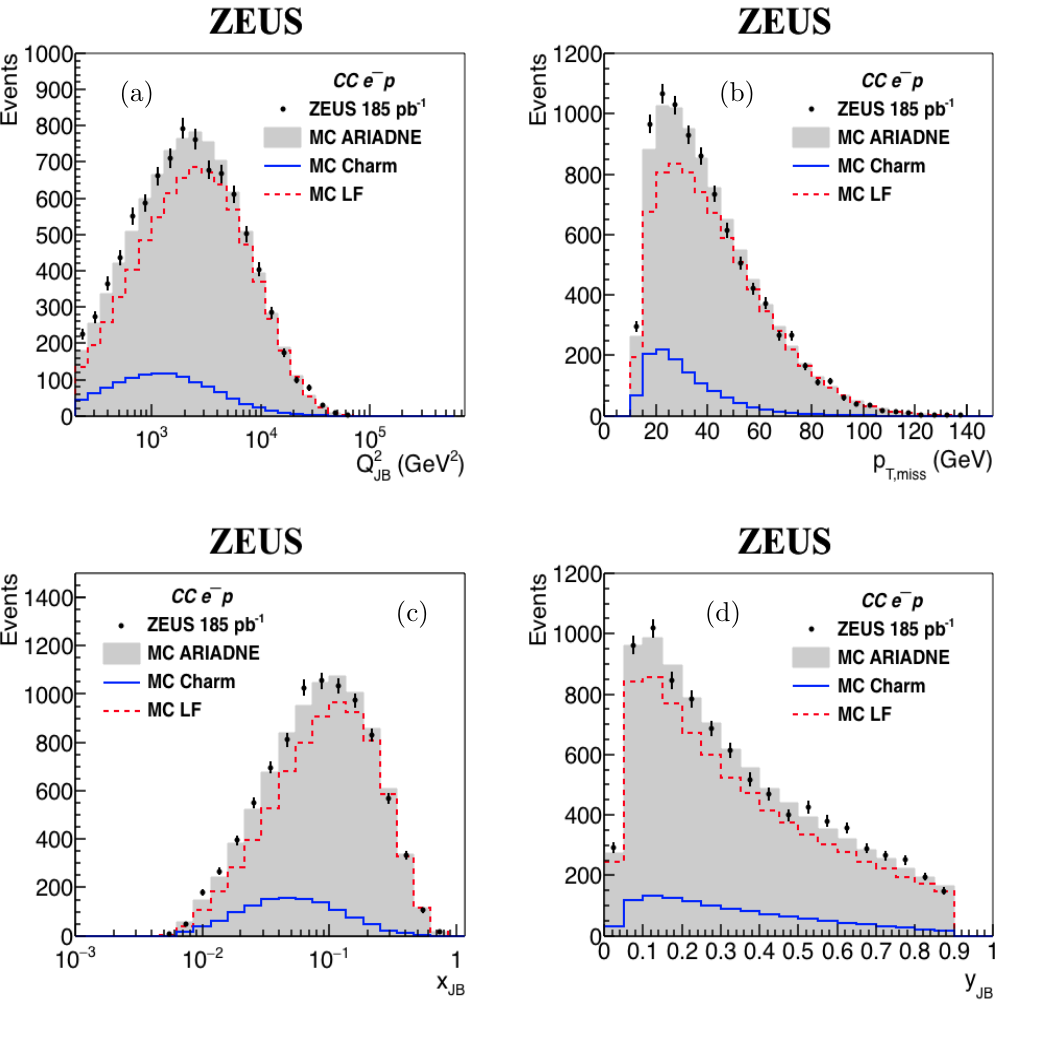
Figure 4. Comparison between data (dots)and MC (histogram) in kinematic variables (a) Q 2 (b) p T; miss , (c) x JB and (d) y JB for e (cid:0) p collisions. The vertical error bars represent the